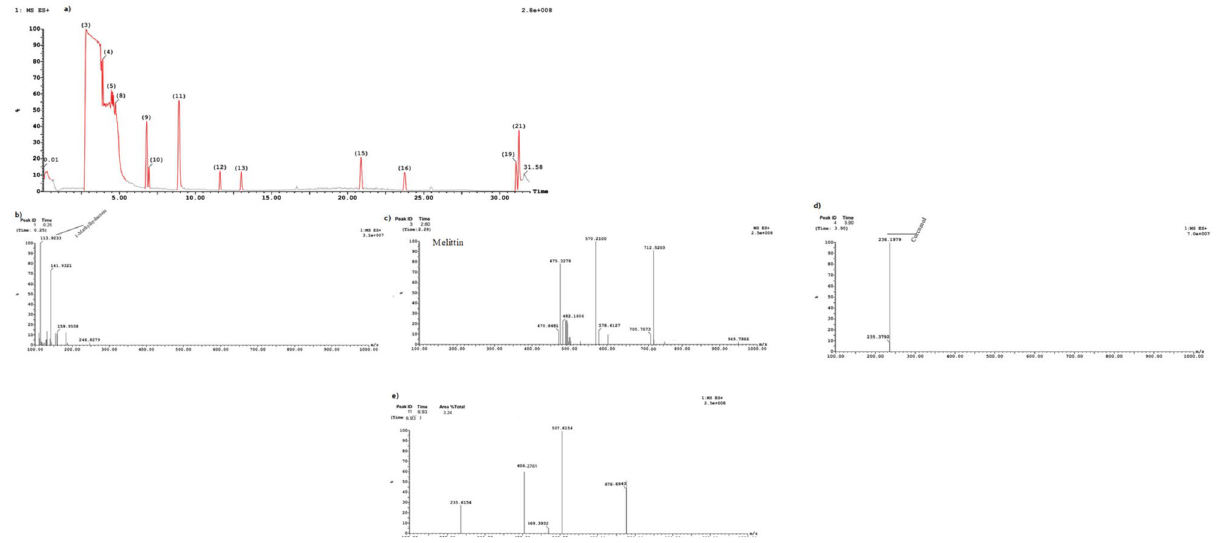
Figure 1. UPLC/ESI–MS analysis and bee